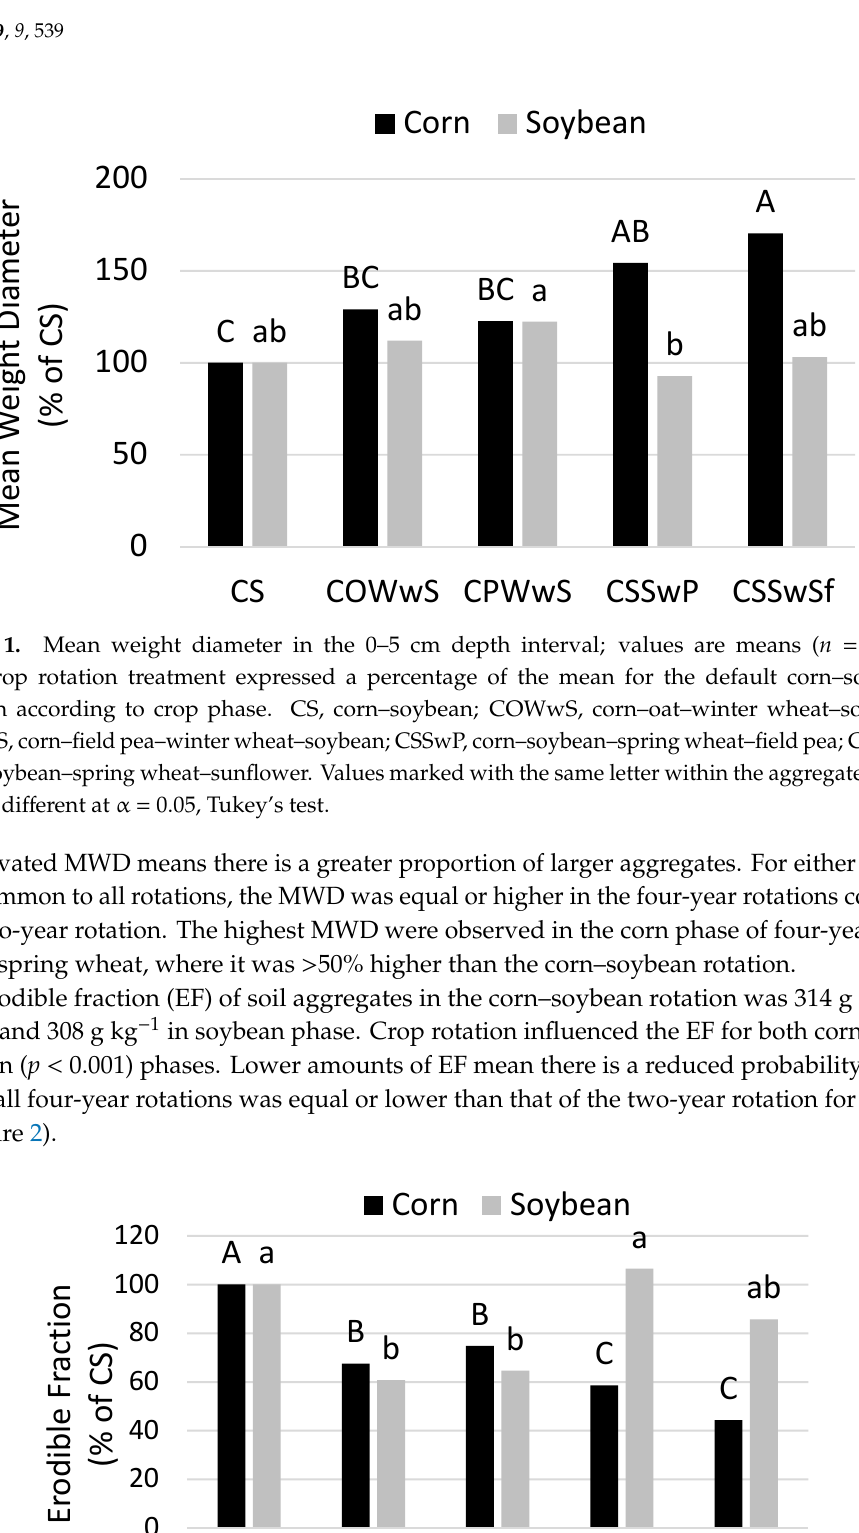
Figure 2. Erodible fraction of soil and the mass fraction of soil < 0.84 mm, in the 0–5 cm depth interval; values are means ( n = 4) for each crop rotation treatment expressed a percentage of the mean for the default corn–soybean rotation according to crop phase. CS, Corn–soybean; COWwS, corn–oat–winter wheat–soybean; CPWwS, corn–field pea–winter wheat–soybean; CSSwP, corn–soybean–spring wheat–field pea; CSSwSf, corn–soybean–spring wheat–sunflower. Values marked with the same letter within the aggregate group are not different at α = 0.05, Tukey’s test.